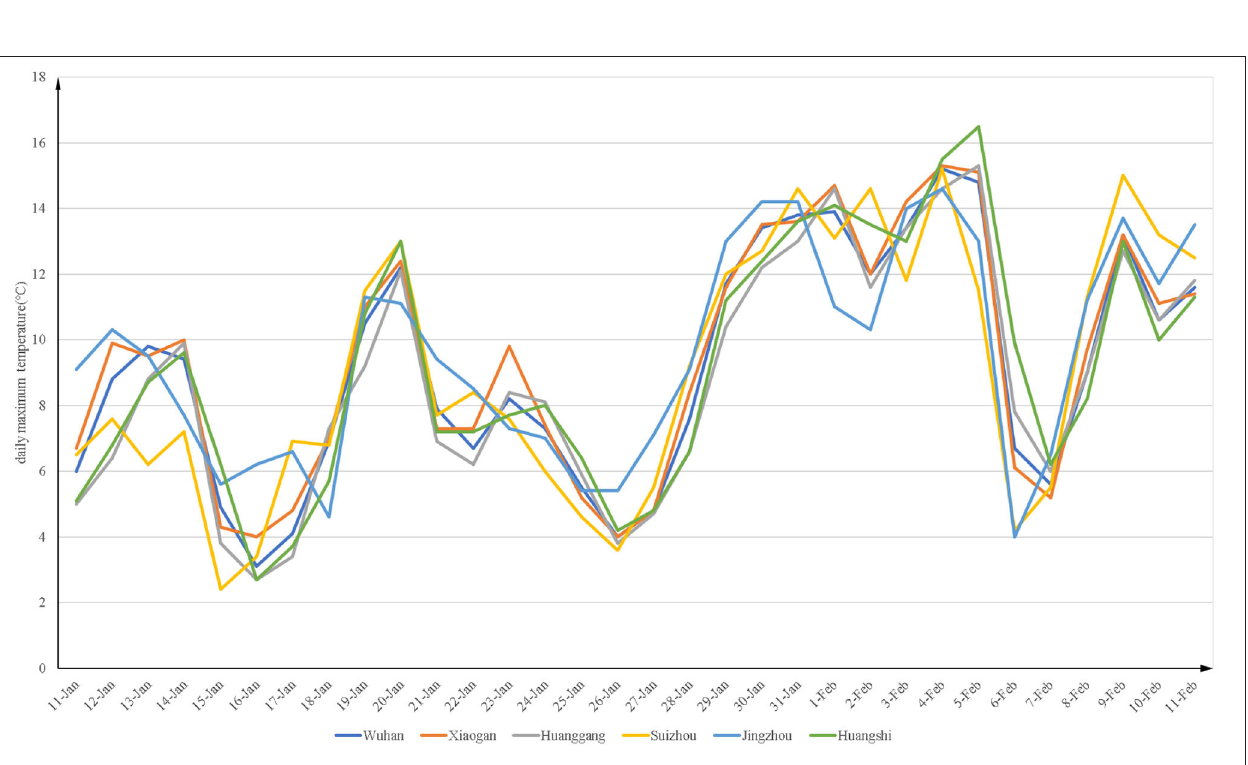
FIGURE 2 | The daily maximum temperature ( ◦ C) from 2020-1-11 to 2020-2-11 in Hubei.